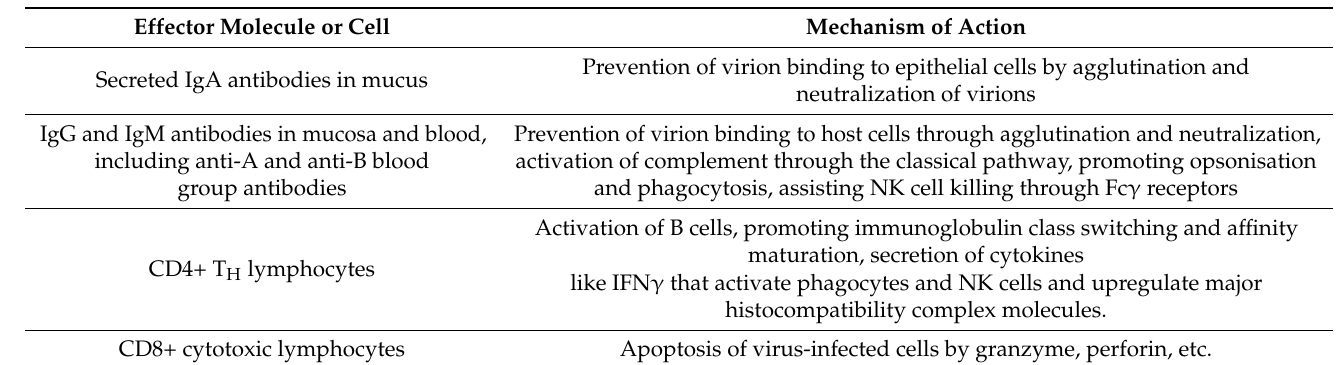
Table 2. Adaptive immune mechanisms that can protect against SARS-CoV-2 infection in the upper respiratory tract. Effector Molecule or